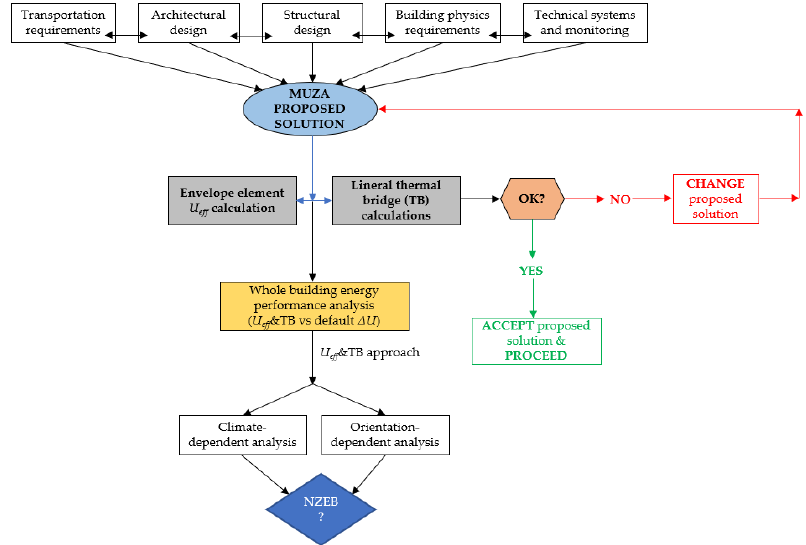
Figure 8. Graphical representation of the research methodology.